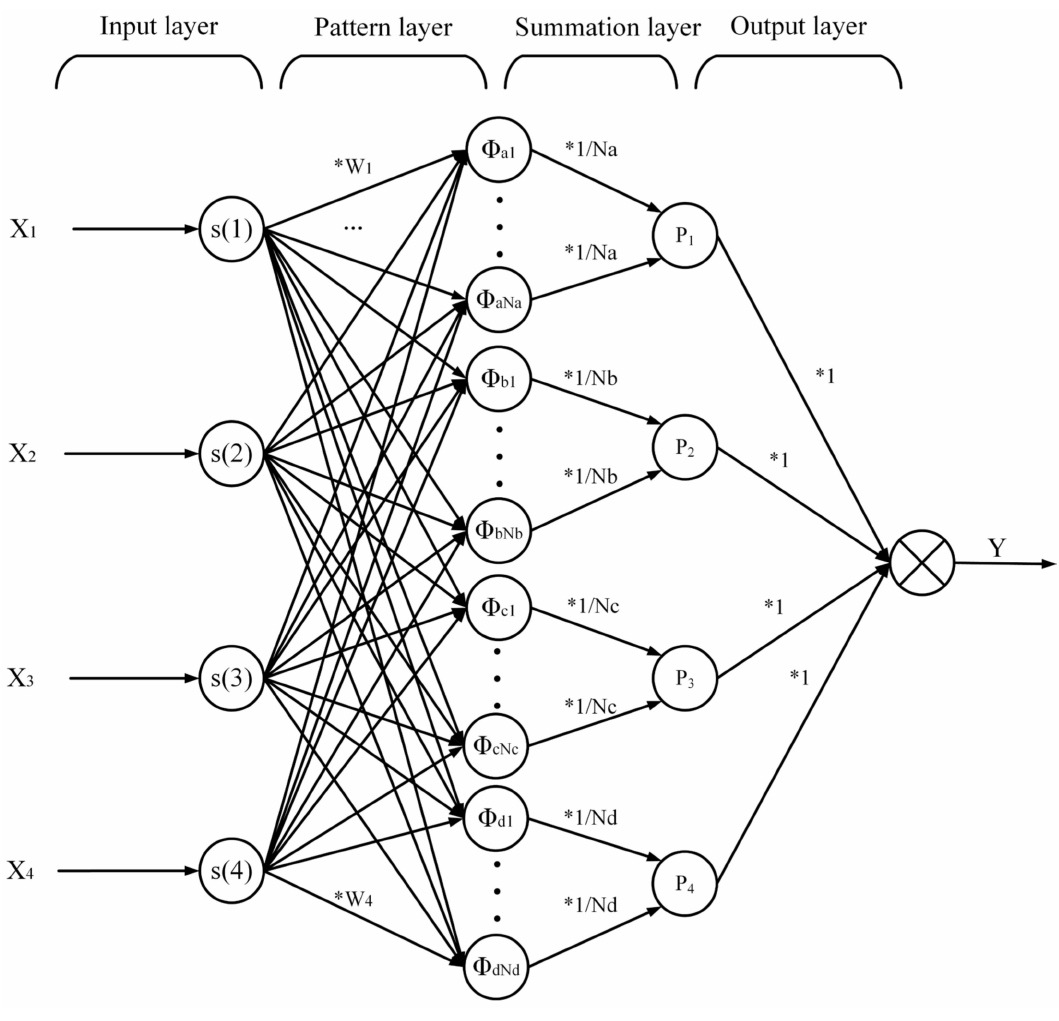
Figure 4. PNN structure